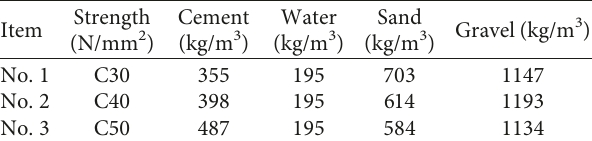
Table 2: Mix proportion of concrete. Item